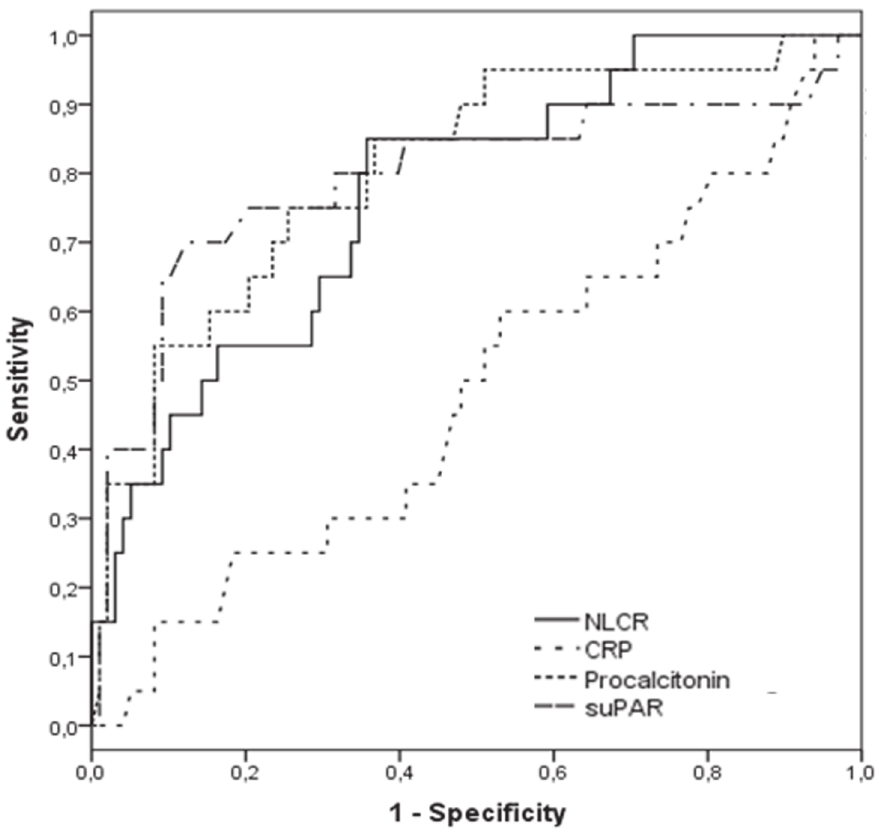
Figure 1. Receiver operating characteristic curves of four biomarkers for differentiating bacteremia from non-bacteremia. C-reactive protein (CRP), neutrophil-lymphocyte count ratio (NLCR), procalcitonin and soluble urokinase plasminogen activator receptor (suPAR) are compared in respect to prediction of positive blood culture. doi:10.1371/journal.pone.0087315.g001 PLOS ONE |